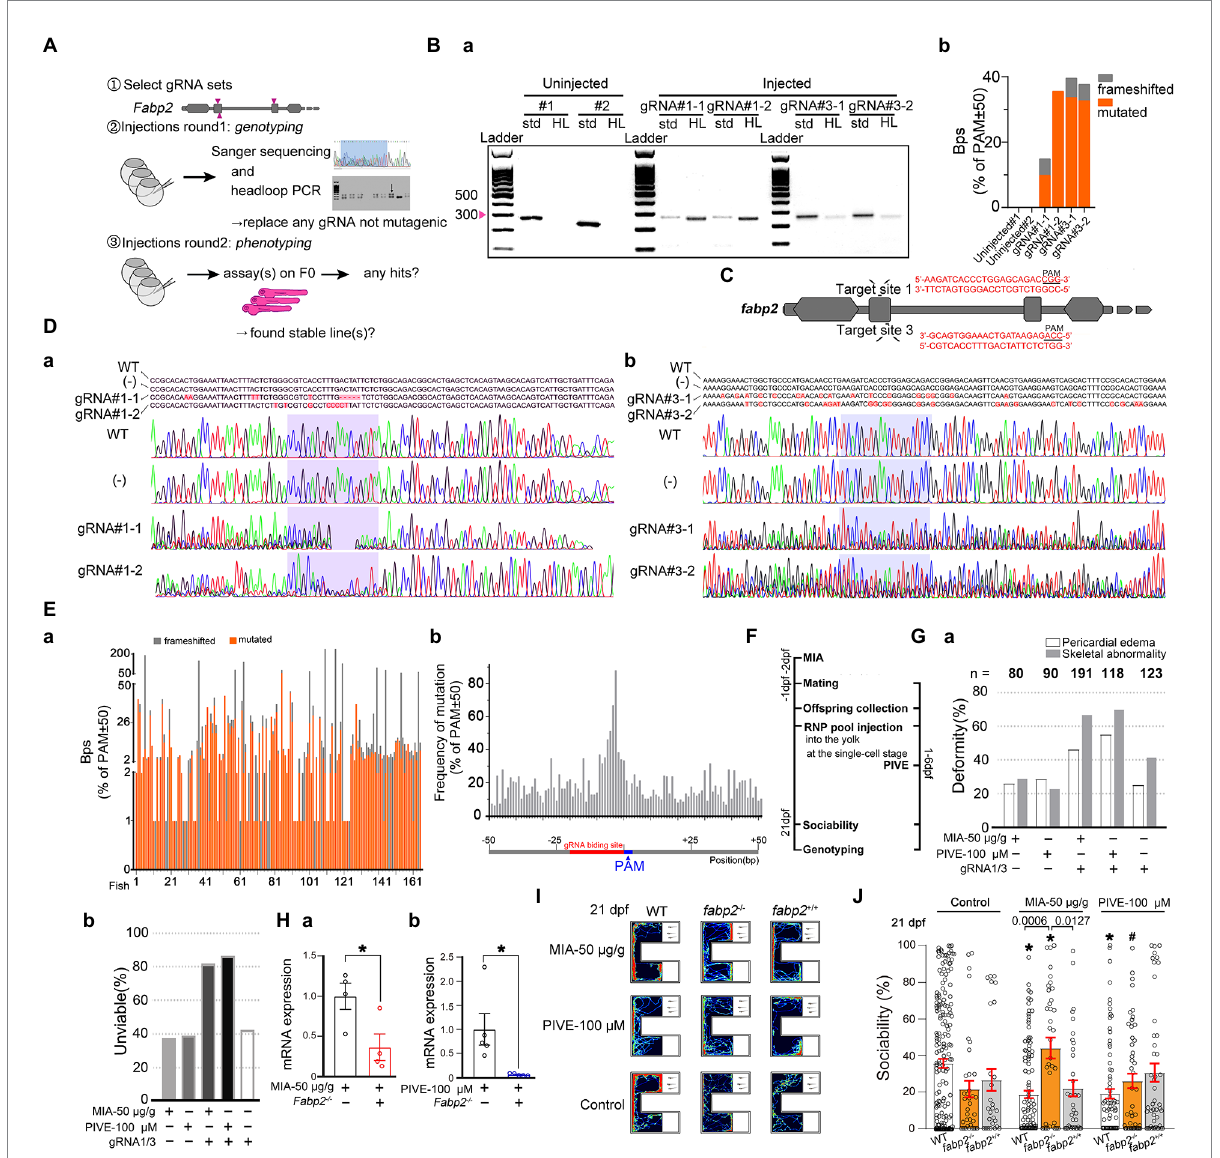
FIGURE 7 Fabp2 gene F0 knockout ameliorated MIA-induced autism-like behaviors. (A) Two rounds F0 knockout of fabp2 gene including selection of gRNAs, verification of mutagenic gRNAs and phenotyping. (Ba) Target loci of fabp2 amplified with the PCR primes used for sequencing (std, standard) or with headloop primer (HL). (Bb) Frameshifted and mutated bps (Sanger sequencing) of the same samples as showed in (Ba) . (C) Schematic diagram of the target site in the zebrafish fabp2 genome. (Dab) Sequencing maps of WT and fabp2 − / − zebrafish. ( − ): gRNA not mutagenic. (Ea) Frameshifted and mutated bps (Sanger sequencing) of all samples (83 fish at 21 dpf; 46 fish at 1 mpf which for finding stable lines). (Eb) Frequency of mutations of R50-PAM-F50 (83 fish at 21 dpf; 46 fish at 1 mpf which for finding stable lines). (F) After maternal poly(I:C) injection (MIA), two-RNP pool was injected into the yolk at the single-cell stage before cell inflation; or two-RNP pool was injected into the yolk at the single-cell stage followed by PIVE to these embryos, and zebrafish were tested for sociability at 21 dpf followed by verification of genotyping. (Ga) Deformity of gRNA injection with MIA or PIVE. (Gb) Unviability of gRNA injection with MIA or PIVE. (Hab) mRNA expressions of fabp2 with MIA or PIVE (MIA: t = 2.72, p < 0.05; PIVE: U = 0.00, p < 0.05). (I) Video tracking of movements of WT or fabp2 − / − larvae with MIA or PIVE at 21 dpf. (J) Sociability of WT or fabp2 − / − larvae with MIA or PIVE at 21 dpf. Fabp2 F0 knockout ameliorated MIA-induced autism-like behaviors ( fabp2 − / − + MIA: Z = 4.06, p < 0.01 vs. fabp2 − / − without MIA). Data are presented as mean ± SEM. * p < 0.05 compared with Control group of the same zebrafish line. # p < 0.05 compared with MIA-50 μ g/g group of the same zebrafish line. Detail about the n and descriptive data for each group and statistical analysis results could be found in Additional file 11: File